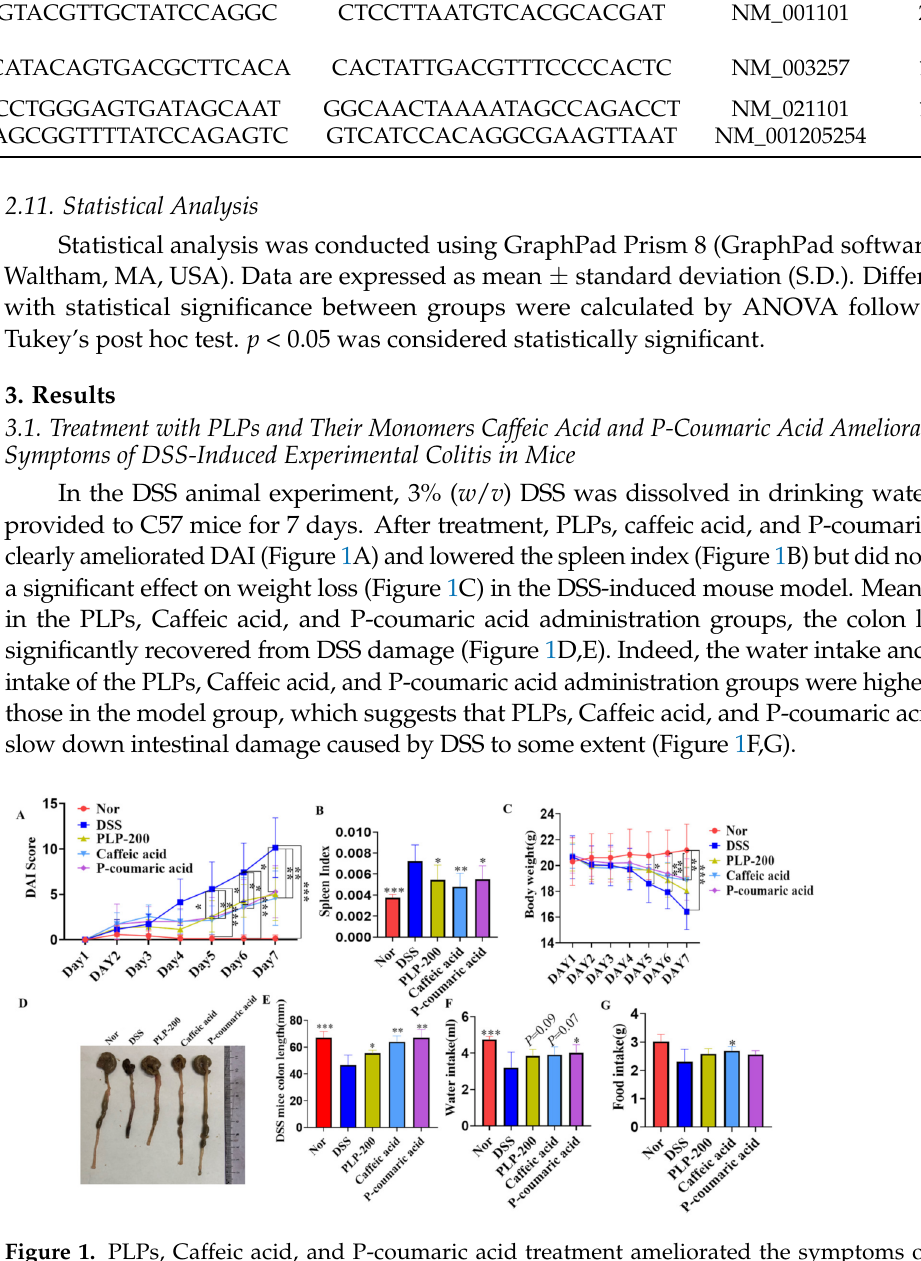
Figure 1. PLPs, Caffeic acid, and P-coumaric acid treatment ameliorated the symptoms of DSS- induced experimental colitis in mice ( A – G ). Disease activity index (DAI) ( A ). Spleen index ( B ). Loss of basal body weight ( C ). Colon length measured for each group ( D , E ). Water intake and food intake ( F , G ). Nor: normal control mice; DSS: colitis model control mice fed dextran sulphate sodium